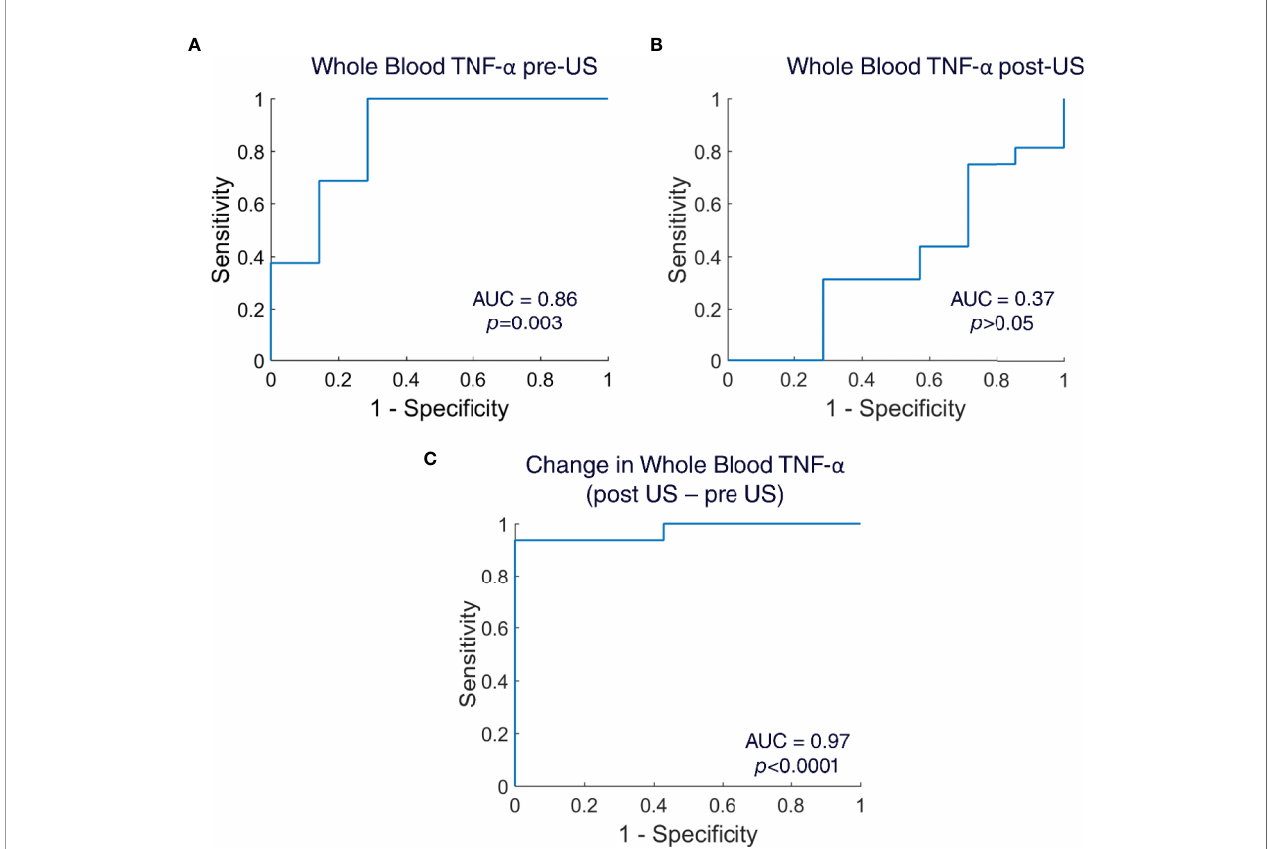
FIGURE 4 | Receiver operating curves (ROC) for whole blood TNF- a . (A) ROC created for whole blood TNF- a pre-US samples (n=23 animals; Area Under the Curve=0.86; Mann Whitney U-test, p=0.003). (B) ROC created for whole blood TNF- a post-US samples (n=23 animals; Area Under the Curve=0.37; Mann Whitney U-test, p>0.05). (C) ROC created for change in whole blood TNF- a (post US – pre US) (n=23 animals; Area Under the Curve=0.97; Mann Whitney U-test,